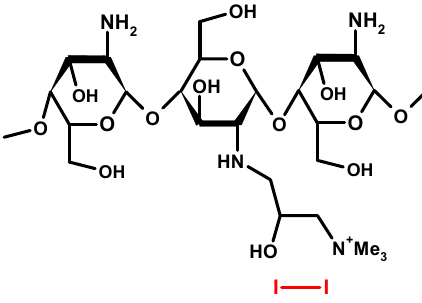
Figure 1. Structure of povidone - iodine ( PVP-I) (polyvidone iodine, iodopovidone) [19].